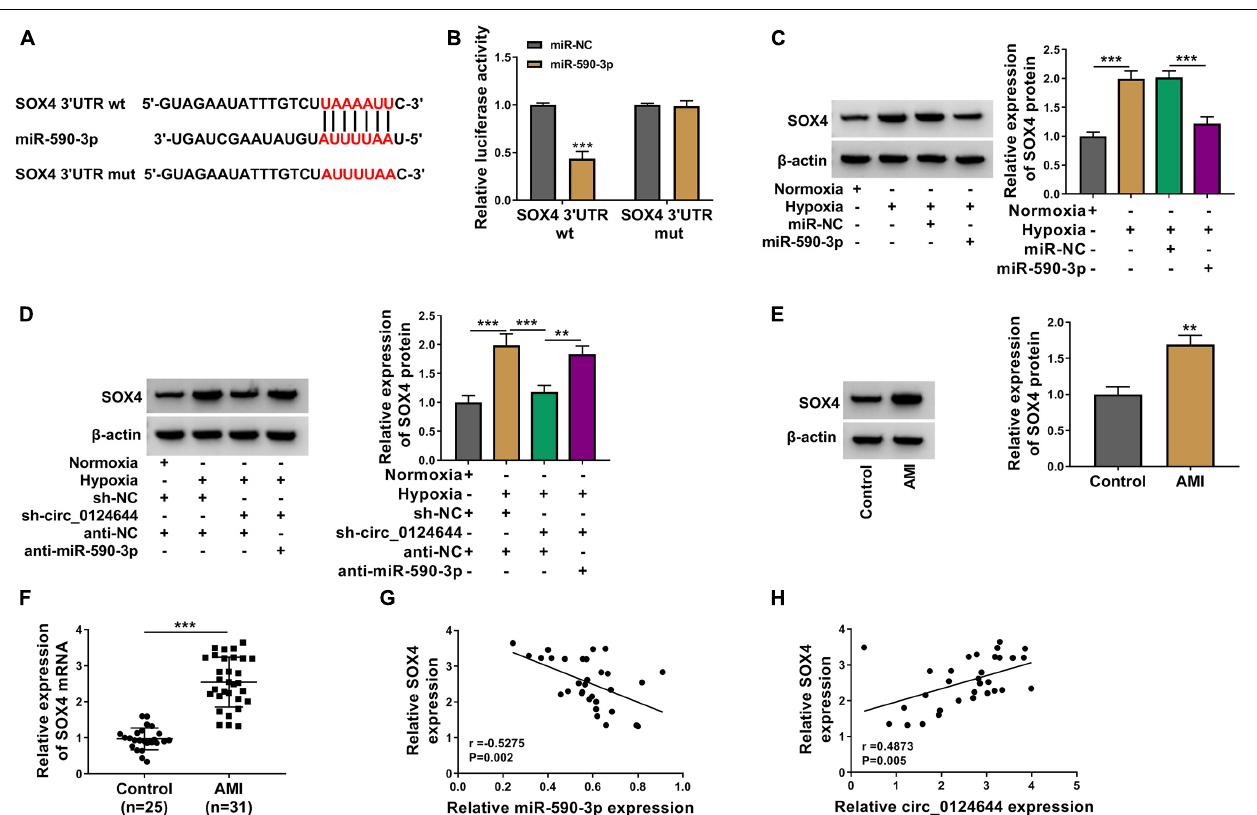
FIGURE 6 | SOX4 could be targeted by miR-590-3p. (A) The predicted and mutated binding sites between SOX4 3 (cid:48) UTR and miR-590-3p were shown. (B) Dual-luciferase reporter assay was used to confirm the interaction between SOX4 and miR-590-3p. (C) AC16 cells were transfected with miR-NC or miR-590-3p mimic, followed by treated with hypoxia. AC16 cells treated with normoxia were used as control. The protein expression of SOX4 was analyzed using WB analysis. (D) AC16 cells were transfected with sh-NC + anti-NC, sh-circ_0124644 + anti-NC, sh-circ_0124644 + anti-miR-590-3p, followed by treated with hypoxia. Normoxia-treated AC16 cells transfected with sh-NC + anti-NC were used as control. WB analysis was used to detect SOX4 protein expression. (E,F) The protein and mRNA expression levels of SOX4 in the serum of AMI patients and healthy control volunteers were evaluated using WB analysis and qRT-PCR. (G,H) The correlation between SOX4 and miR-590-3p or circ_0124644 was assessed by Pearson correlation analysis. ** P < 0.01, *** P <